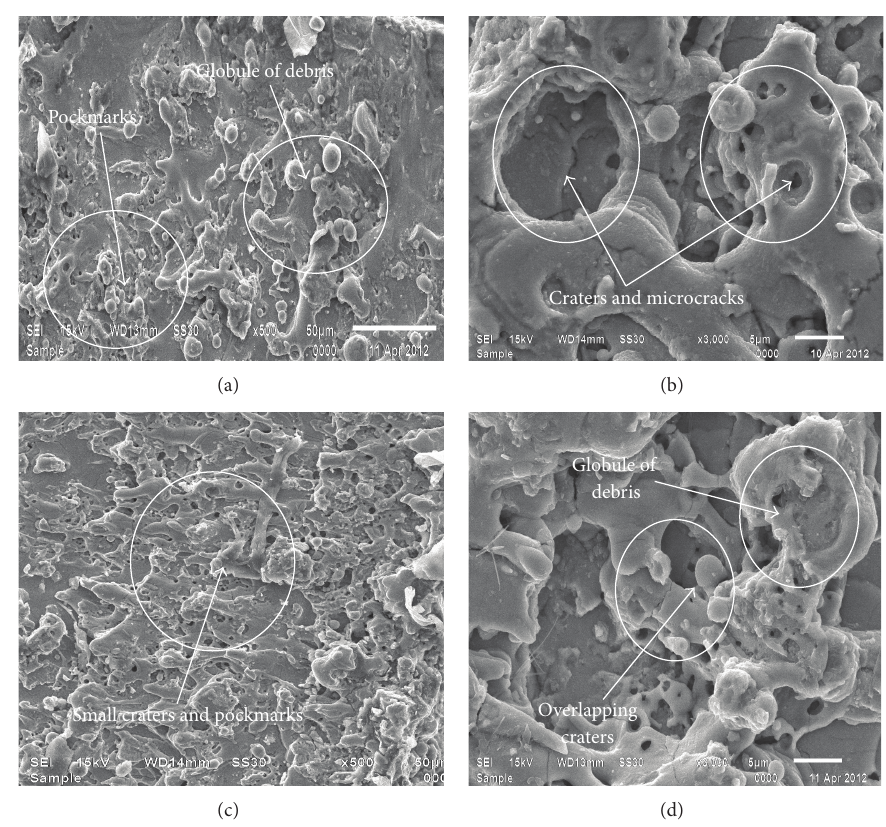
Figure 5: SEM micrograph (1000x, 2000x, 3000x, and 500x): (a) experiment no. 1, at 𝑇 on = 1.1 𝜇 s, 𝑇 off = 28 𝜇 s, Ip = 200 A, SV = 50 V, WF = 7m/min, WT = 500 grams; (b) experiment no. 35, at 𝑇 on =1.1 𝜇 s, 𝑇 off = 17 𝜇 s, Ip = 160A, SV = 40 V, WF = 7m/min, WT = 950 grams; (c) experiment no. 15, at 𝑇 on = 0.7 𝜇 s, 𝑇 off = 28 𝜇 s, Ip = 120A, SV = 50V, WF = 7m/min, WT = 500 grams; (d) experiment no. 6, at 𝑇 on = 1.1 𝜇 s, 𝜇 s, Ip = 160A, SV = 40 V, WF = 4m/min, WT = 950 𝑇 off = 28